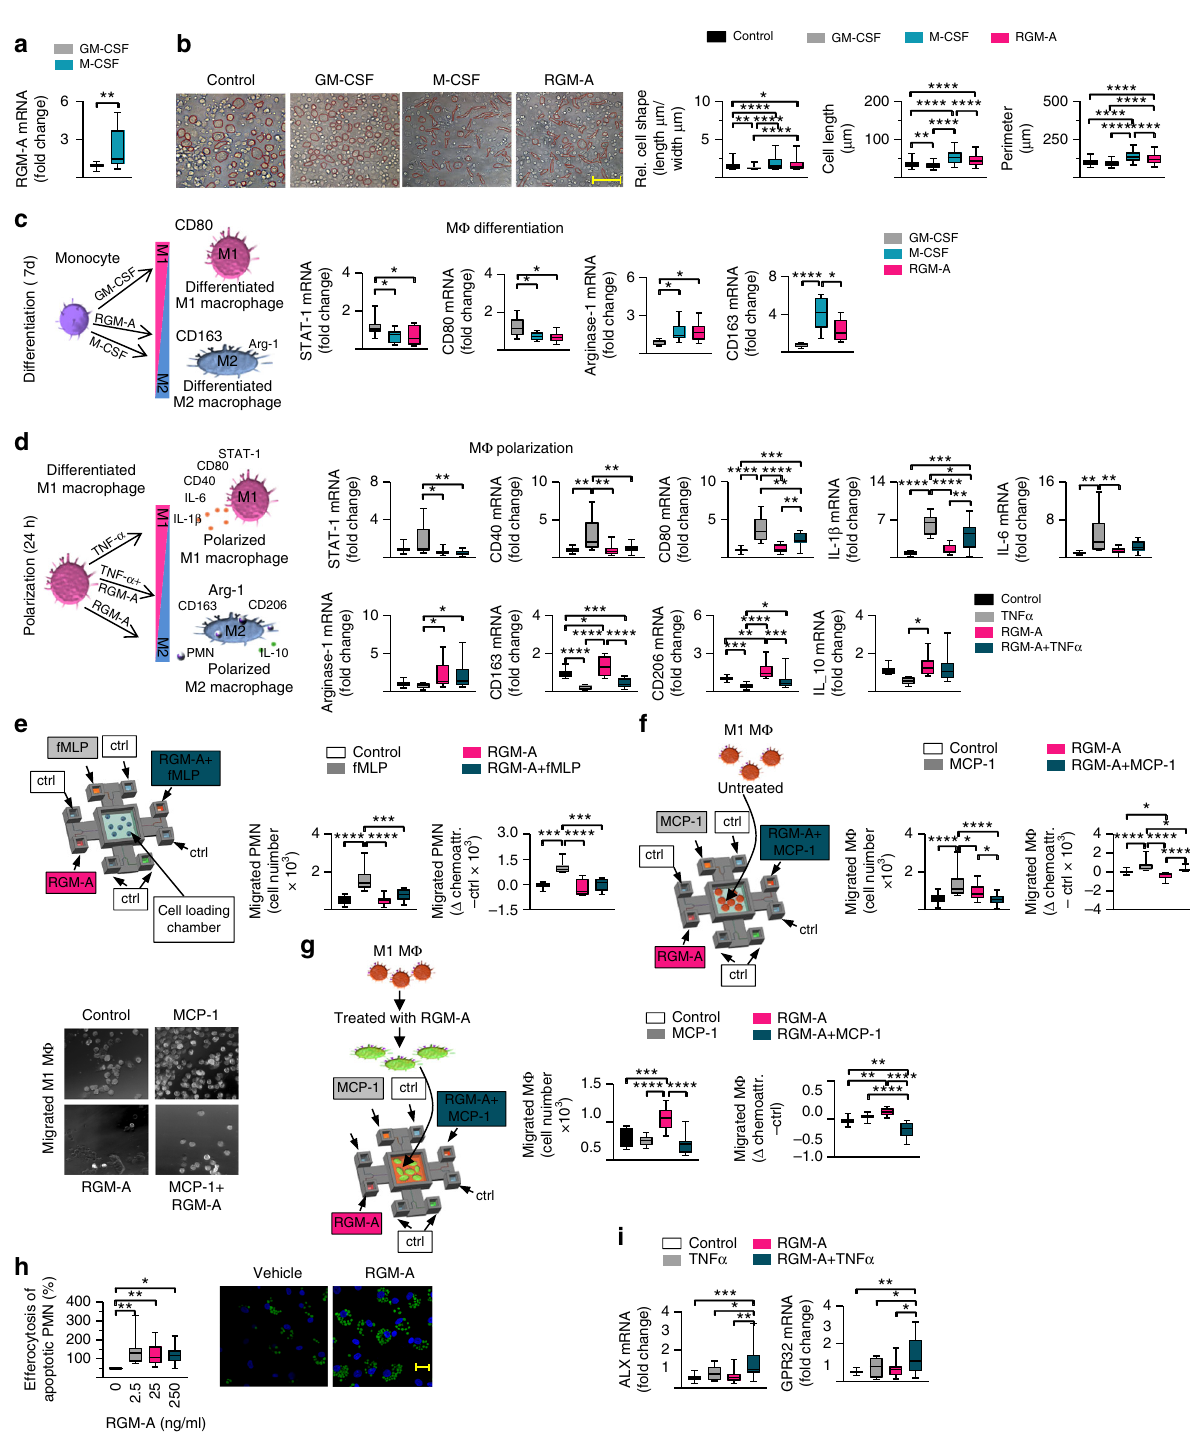
(Fig. 1h). The G protein-coupled receptors ALX/FPR2 and GPR32